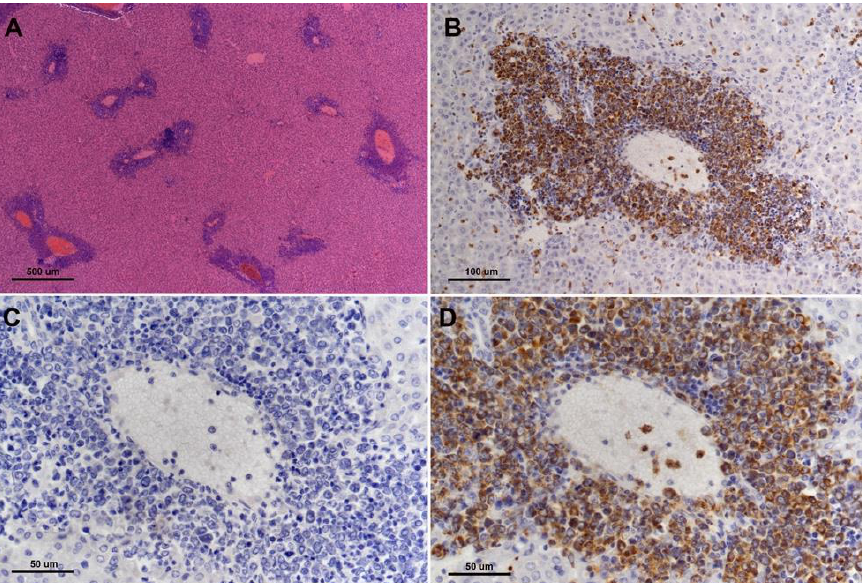
Figure 2. Myeloid leukemia involvement of liver of TP53 homozygous mutant hamster. There are multifocal infiltrates of neoplastic cells predominantly involving the portal triads (( A ), H&E, 4× objective lens). Infiltrating cells surrounding hepatic portal veins are strongly myeloperoxidase positive (( B , D ), 20× and 40× objective lens, respectively). ( C ) shows corresponding negative control (MPO-specific primary antibody is substituted with normal rabbit immunoglobulin on a serial step section, 40× objective lens) for image in ( D ) (from [49, with permission]).